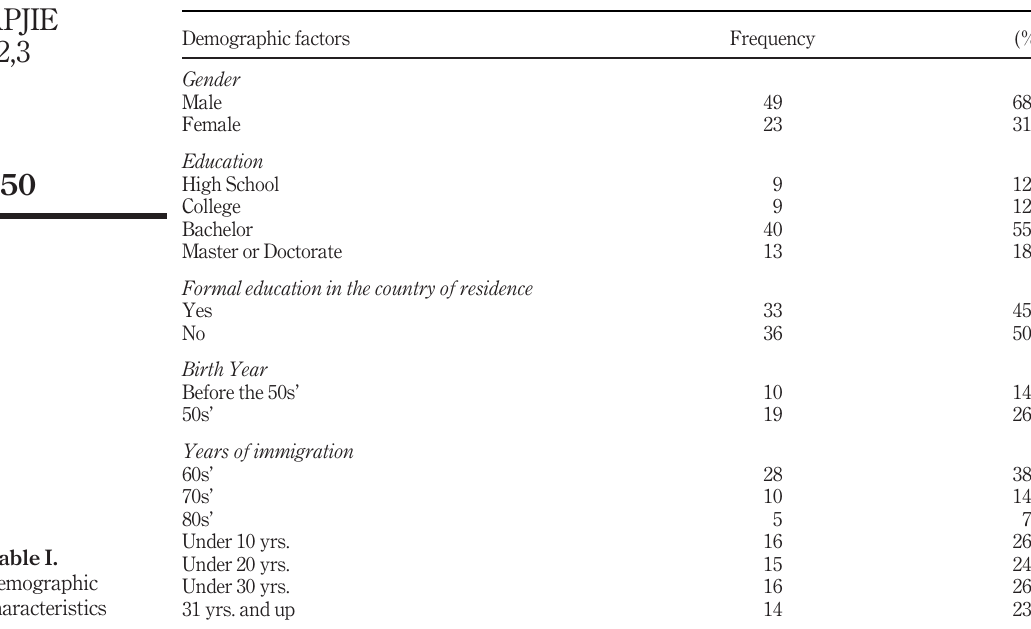
Residing country